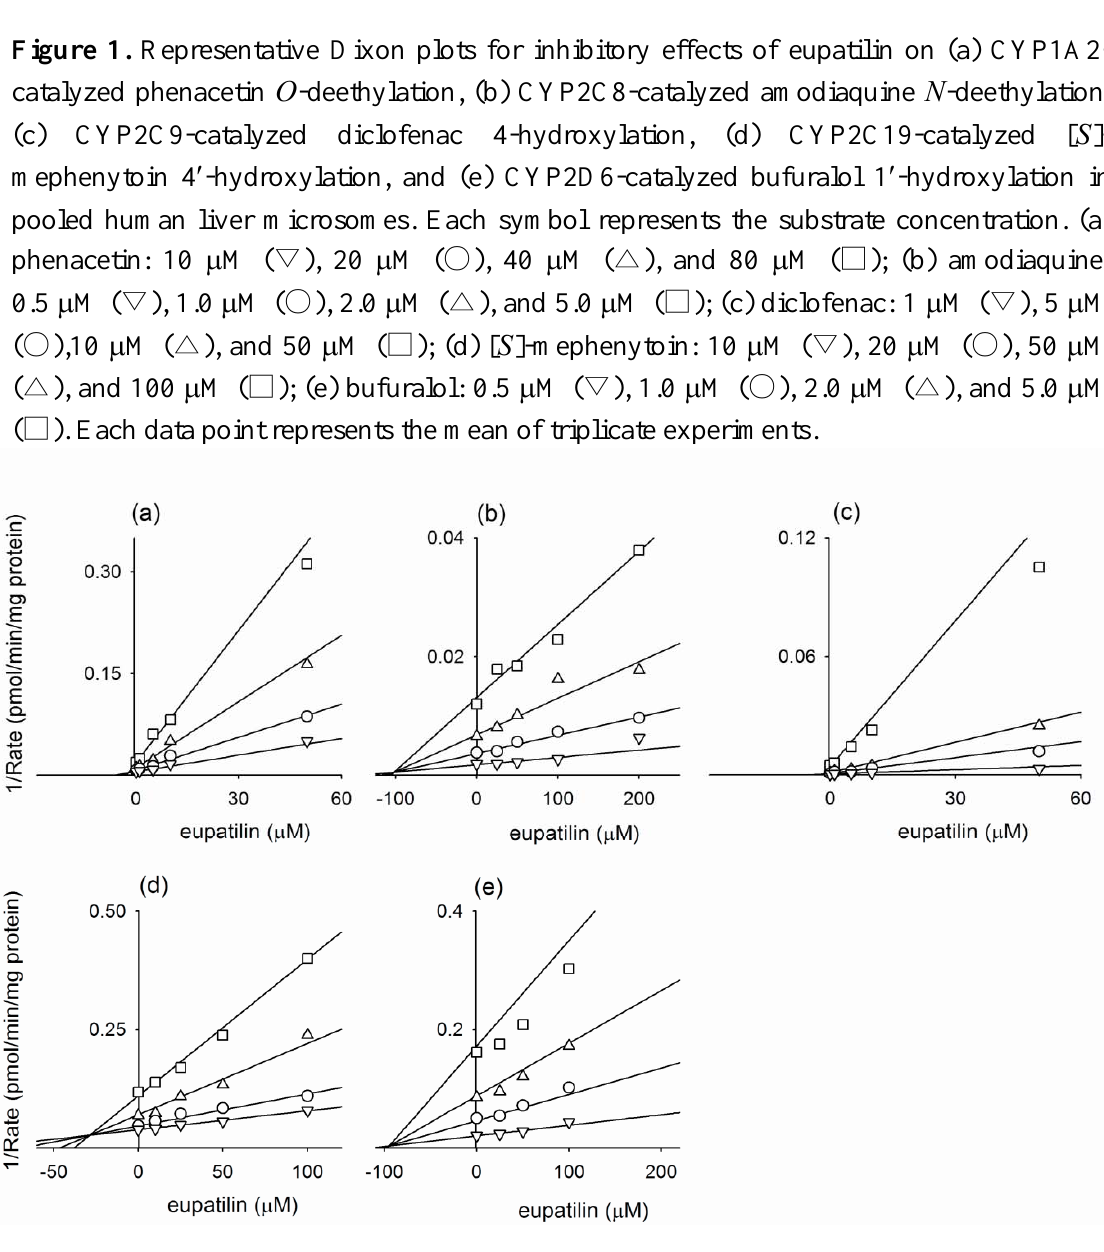
Figure 1. Representative Dixon plots for inhibitory effects of eupatilin on (a) CYP1A2- catalyzed phenacetin O -deethylation, (b) CYP2C8-catalyzed amodiaquine N -deethylation, (c) CYP2C9-catalyzed diclofenac 4-hydroxylation, (d) CYP2C19-catalyzed [ S ]- mephenytoin 4 ′ -hydroxylation, and (e) CYP2D6-catalyzed bufuralol 1 ′ -hydroxylation in pooled human liver microsomes. Each symbol represents the substrate concentration.